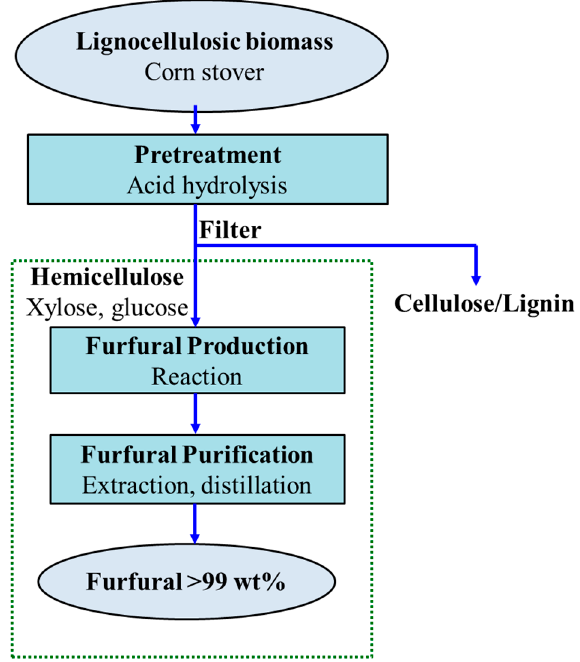
Figure 1. Schematic flowsheet of the furfural production process from lignocellulosic